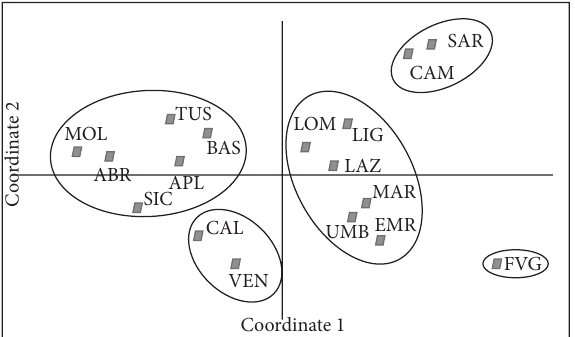
Figure 1: Principal Coordinates Analysis (PCoA) plot of the olive varieties based on the first two principal coordinates (coord. 1 =